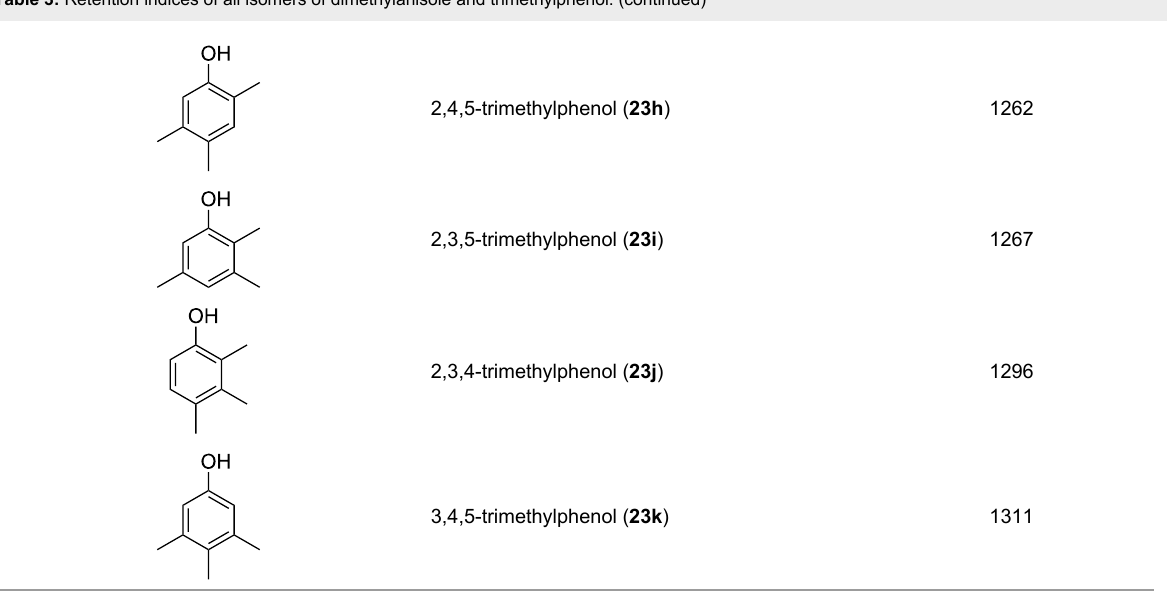
Table 3: Retention indices of all isomers of dimethylanisole and trimethylphenol. (continued)